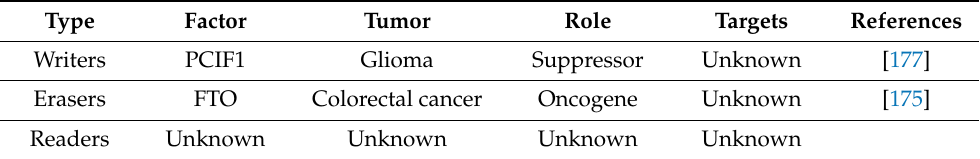
Table 3. Role of m 6 Am in cancer. FTO—fat mass and obesity-associated gene; PCIF1—phosphorylated CTD-interacting factor